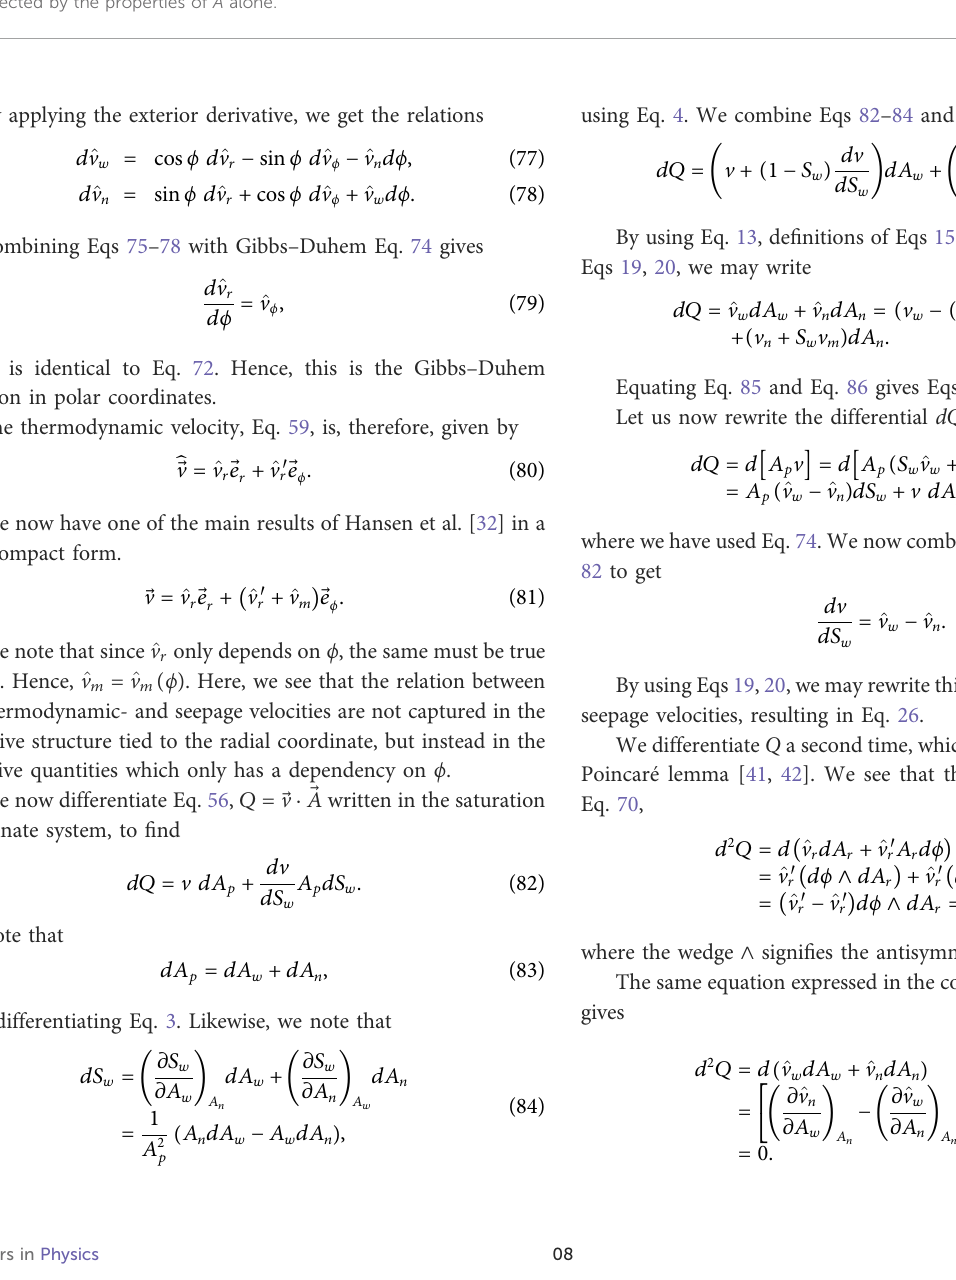
(cid:10) (cid:1) v and (cid:1) v , ^ v m , is orthogonal to (cid:1) A , and cannot be